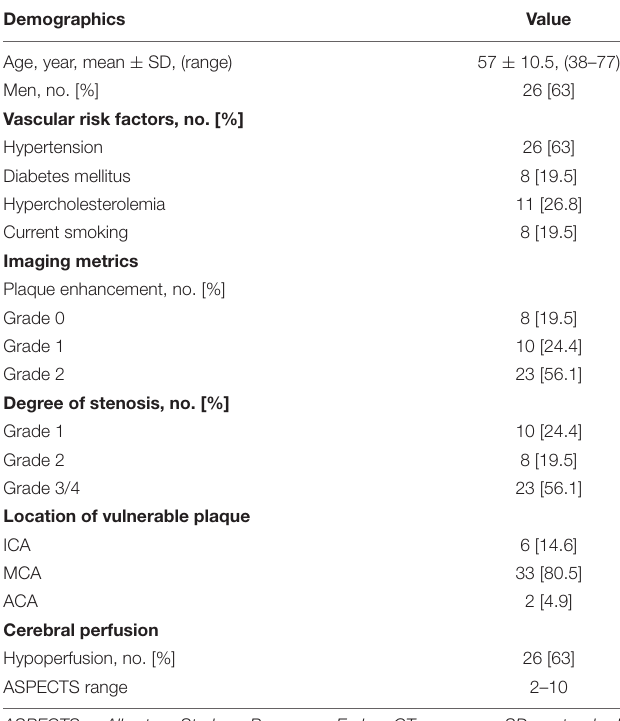
TABLE 1 | Clinical and imaging characteristics of the unilateral intracranial atherosclerosis patients ( n = 41). Demographics Value